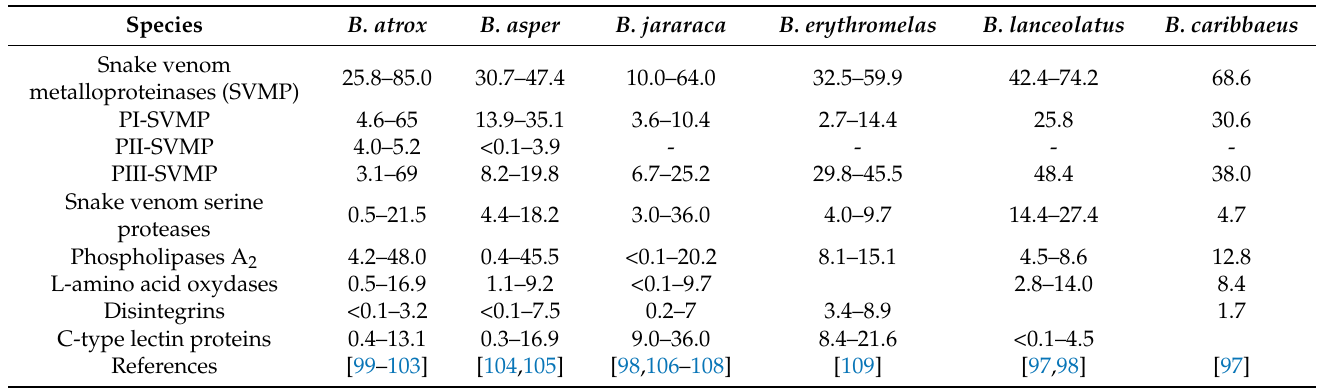
Table 1. Proportions of protein families targeting hemostasis in Bothrops